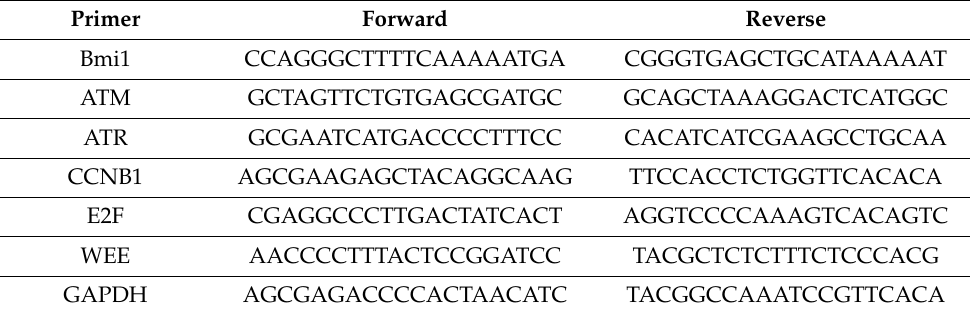
Table 1. Forward and reverse primer